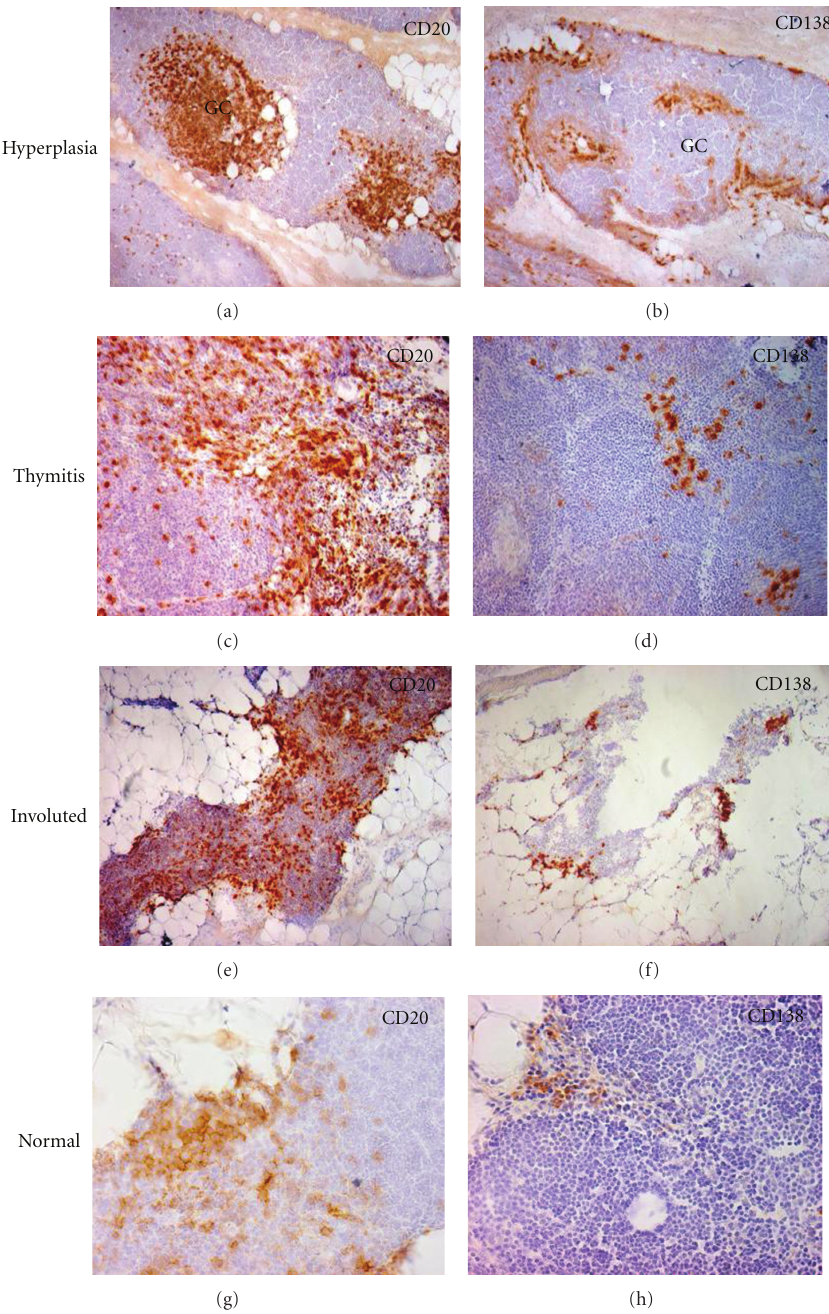
Figure 2: Presence of B cell lymphoid infiltrates and plasma cells in MG and control thymuses analysed for EBV detection. (a, b) Thymus with follicular hyperplasia (MG1). CD20+ B cells aggregate to form a germinal center (GC) in the thymic medulla (a). Many CD138+ plasma cells are present at the periphery of a GC (b). (c, d) Thymus with thymitis (MG11). Many CD20+ B cells (c) and CD138+ plasma cells (d) are sparse throughout the medullary infiltrates. (e, f) Involuted thymus (MG17). The residual thymic parenchyma contains lymphoid infiltrates with numerous CD20+ B cells (e) and CD138+ plasma cells (f). (g, h) Normal thymus from an adult healthy subject. Some CD20+ cells (g) and rare CD138+ plasma cells (h) are present in the thymic parenchyma. Magnifications: × 10 (a, b, e, f); × 20 (c, d); × 40 (g, h).